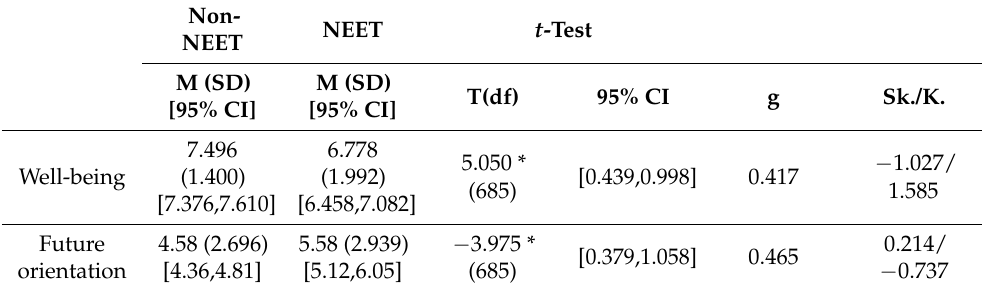
Table 2. Descriptive analyses, t -test, and effect sizes for NEET group and non-NEET group. Non-